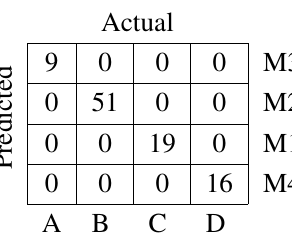
Figure 7. Confusion matrix for DTW-based